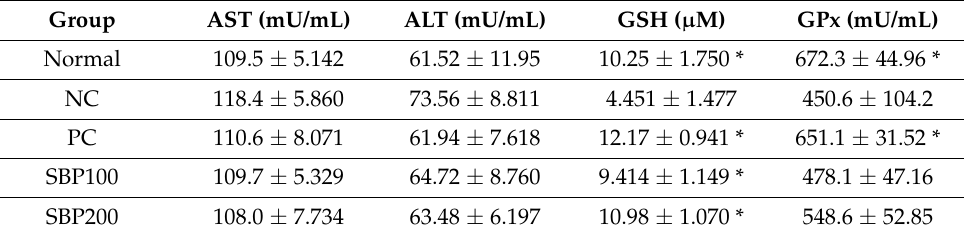
Table 4. AST and ALT levels in the plasma and antioxidant enzyme levels in the livers of OVA/Alum- sensitized mice.